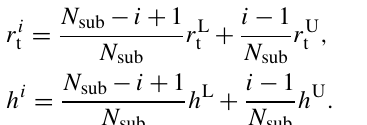
The iterative calculation to obtain S at each sublevel is de- scribed